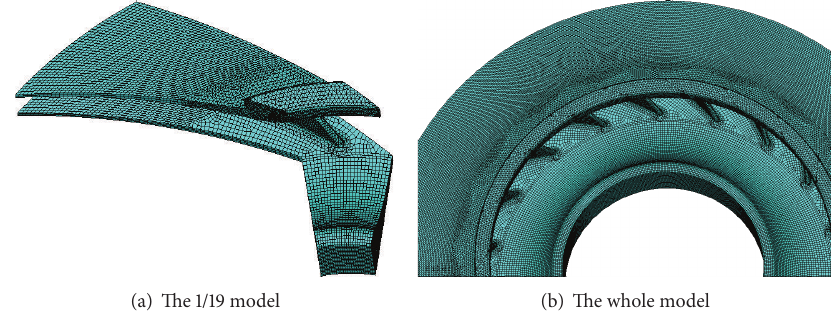
Figure 8: Finite element model of the impeller.